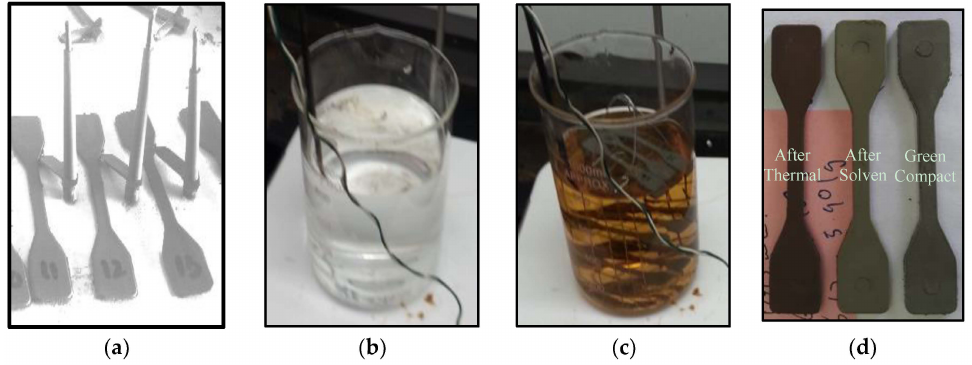
Figure 11. ( a ) Injected part ( b ) Colorless Hexane ( c ) Color of the hexane solvent changing to orange after green compact being immersed into it during the third hour; ( d ) comparison of part dimension after thermal and solvent extraction with green